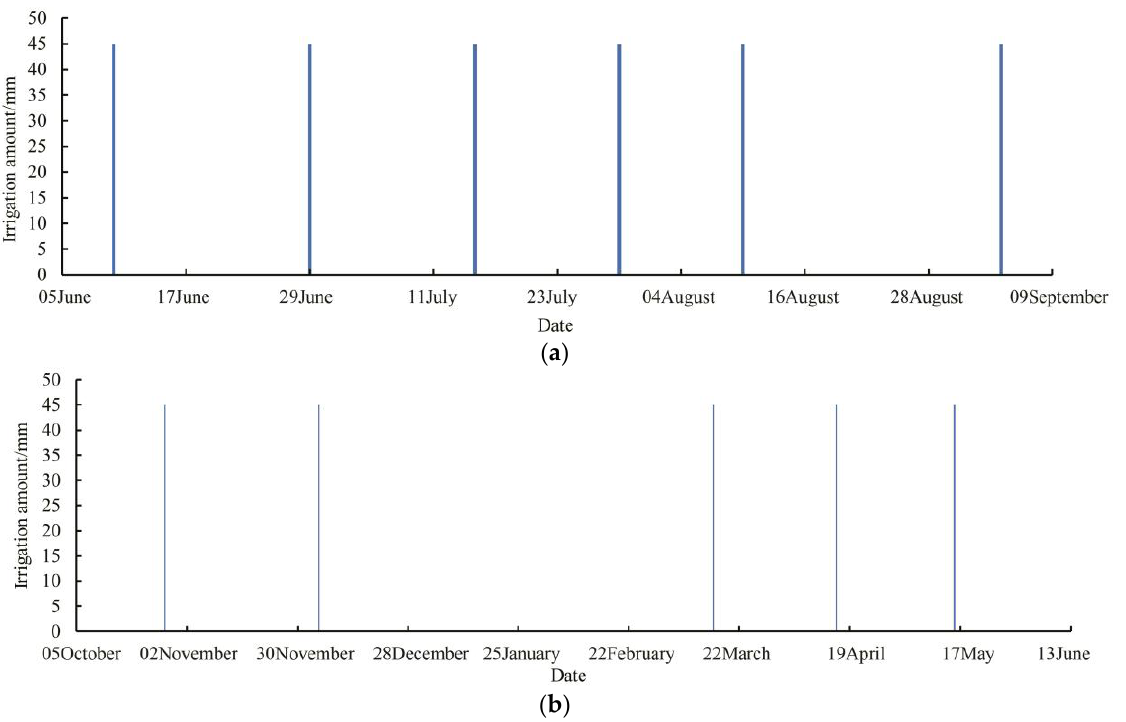
Figure 3. Irrigation amount for the whole growth period of crops. ( a ) Summer maize; ( b ) Winter